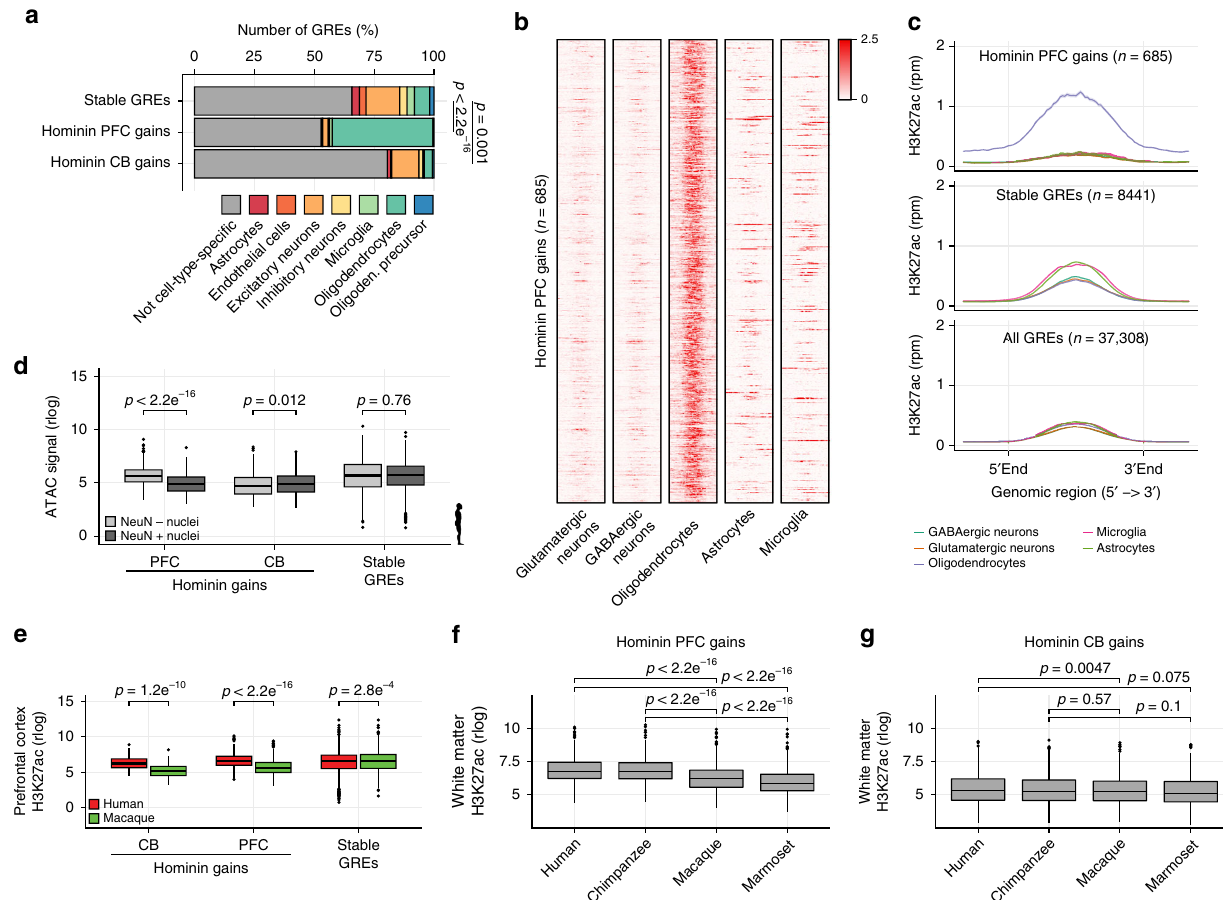
Fig. 2 Hominin-speci fi c gains are oligodendrocyte-speci fi c. a Bar plot showing cell-type-speci fi c ATAC peaks in hominin-speci fi c gains in PFC and CB and stable GREs. Difference in oligodendrocyte-speci fi c open chromatin frequency was calculated using a Fisher ’ s exact test. b Heatmap showing H3K27ac enrichment for 685 scaled hominin-speci fi c PFC gains, analyzed in different cell types as indicated. Heatmap colors indicate H3K27ac enrichment (rpm). c Metaplot analysis showing the average H3K27ac enrichment pro fi le in different cell types for hominin-speci fi c PFC gains, stable and all GREs. d Box plot showing normalized ATAC signal for hominin-speci fi c gains and stable GREs in nuclei FANS sorted for NeuN. Dissimilarities between distributions were calculated using a Student ’ s t test. e Box plots showing normalized H3K27ac enrichment for hominin-speci fi c gains and stable GREs in prefrontal cortex in both human and rhesus macaque. Dissimilarities between distributions were calculated using a Student ’ s t test. f Box plots showing normalized H3K27ac enrichment for hominin-speci fi c PFC gains in white matter tissue per species. Dissimilarity between distributions was calculated using a Student ’ s t test. g Box plots as in ( f ) but for normalized H3K27ac enrichment on hominin-speci fi c CB gains. Bottom and top of all box plots are the fi rst and third quartile. The line within the boxes represents the median and whiskers denote interval within 1.5× the interquartile range from the median, outlier are depicted as points. Source data are provided in Source Data fi